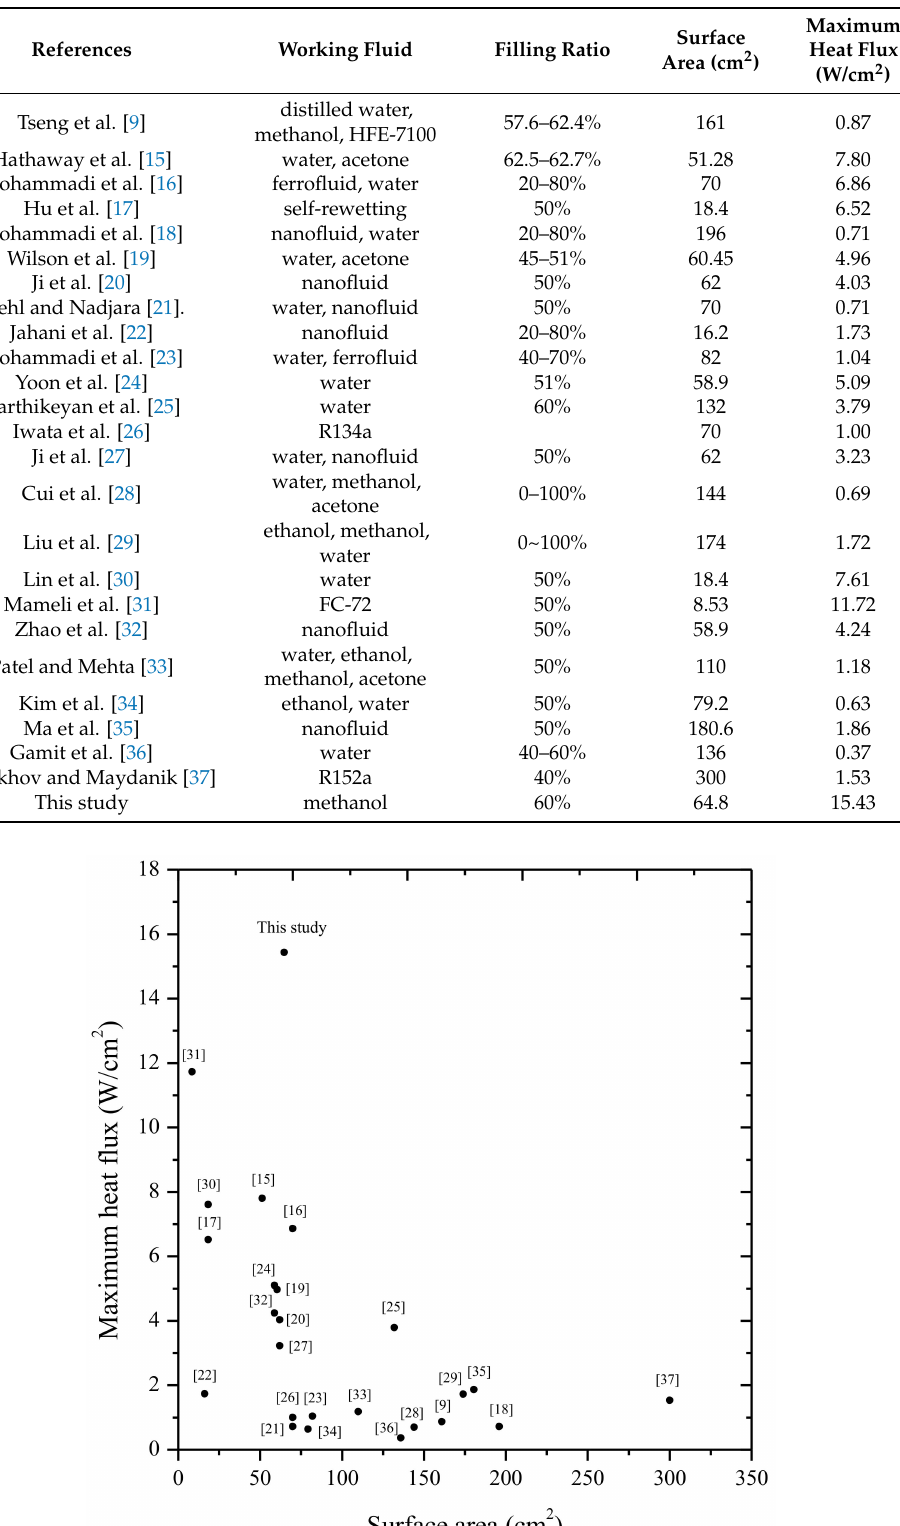
Table 1. References for comparison with this study and the corresponding major parameters.